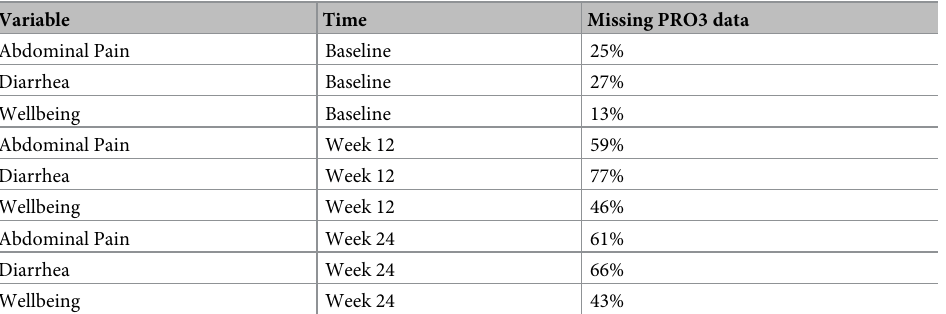
Table 7. Characterization of missing PRO3 elements across all time periods. Proportions correspond to all 56 members of the external cohort.